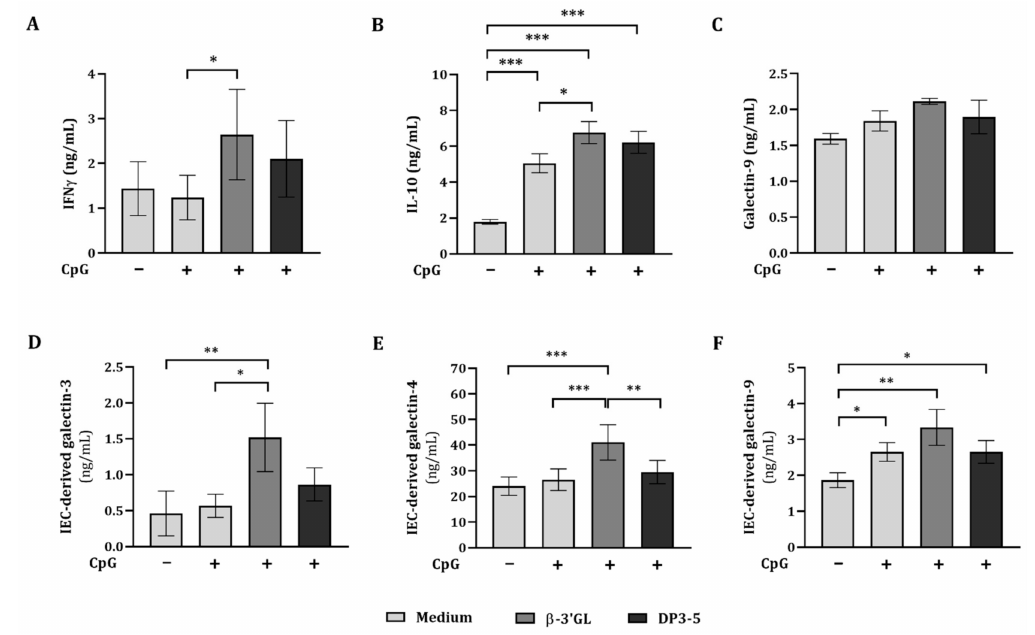
Figure 6. Cytokine and galectin-9 secretion in IEC/PBMC co-culture and IEC-derived galectin secretion at 48 h. IEC were apically exposed to GOS DP3-5 or β -3 (cid:48) GL (0.5% w / v ) in combination with 0.1 µ M CpG, and basolaterally to α CD3/CD28-activated PBMC. After 24 h of incubation, IFN γ ( A ), IL-10 ( B ), and galectin-9 ( C ) were measured in the basolateral compartment. Additionally, after IEC/PBMC co-culture, IEC were washed and incubated in fresh medium for an additional 24 h (48 h in total; 24 h in IEC/PBMC culture and an additional 24 h in IEC culture in medium), after which IEC-derived galectin-3 ( D ), -4 ( E ), and -9 ( F ) were measured in the basolateral supernatant. The data shown are represented as mean ± SEM of n = 6 independent PBMC donors (except for galectin-9 n = 4) (* p < 0.05. ** p < 0.01, *** p <